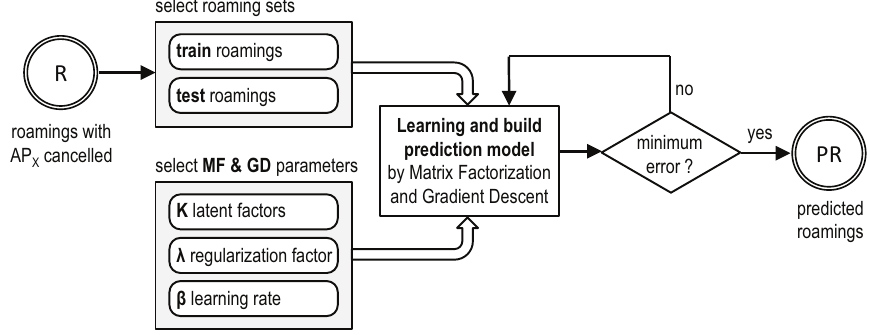
Figure 2. Methodology to generate a prediction model from Matrix Factorisation and Gradient Descent. This model will predict the number of roamings in each AP produced by each user considering a Wi-Fi infrastructure where a particular AP has been